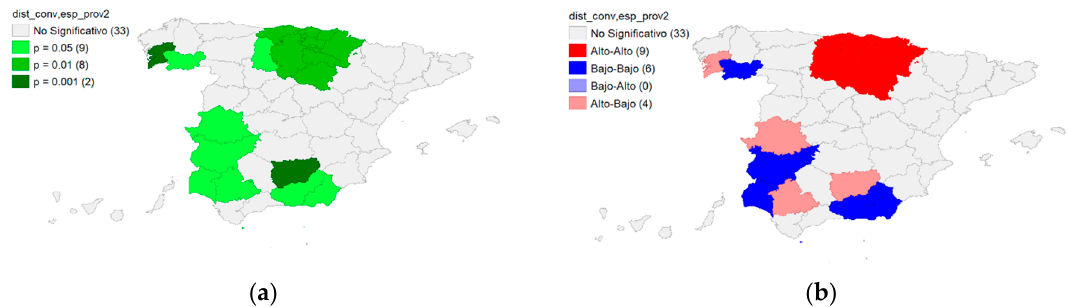
Figure 4. Significance map ( a ) and cluster map ( b ) for Moran’s Local Bivariate Index for success and industrial specializa- tion.